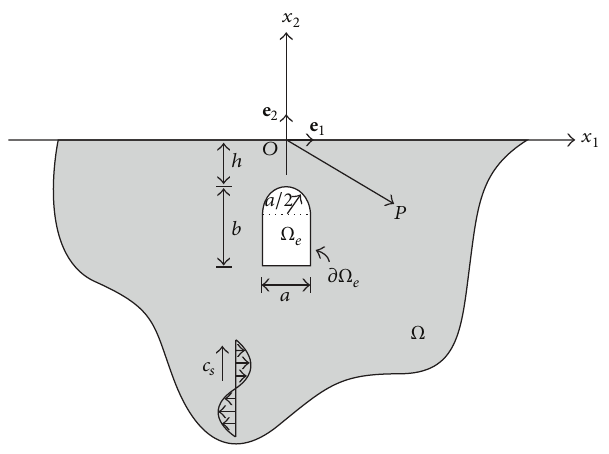
Figure 1: Geometrical scheme.